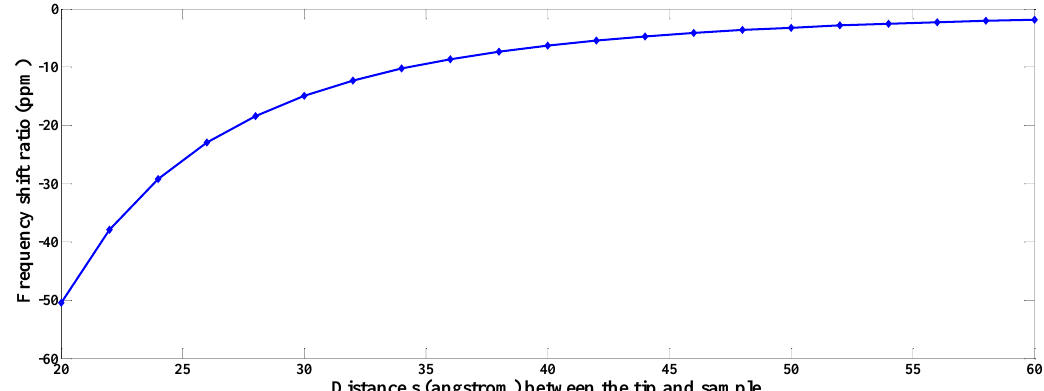
Figure 10. The plot of frequency shift ratio versus the tip-sample distance in far-range regime.